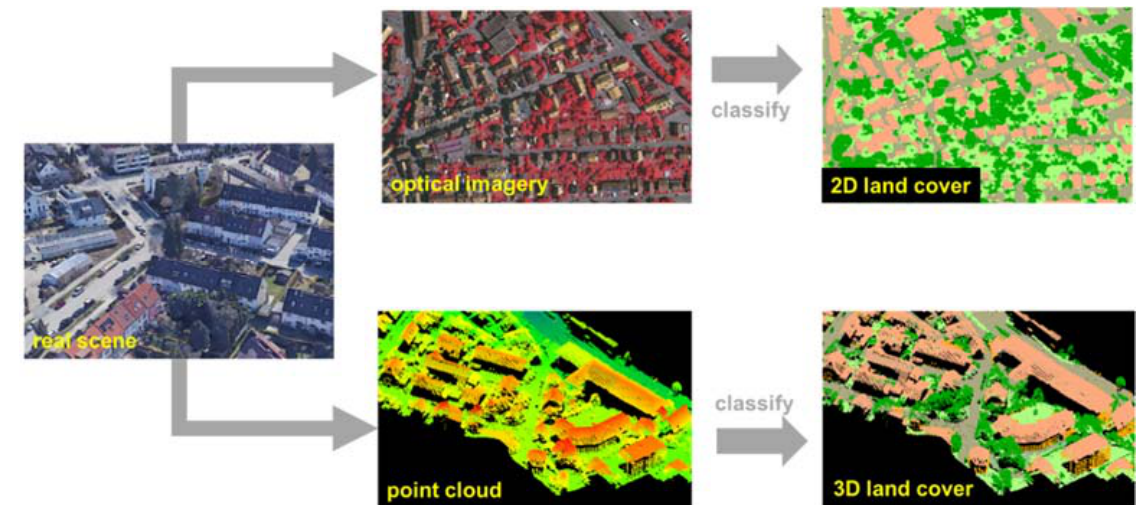
Figure 1. Schematic diagram of two-dimensional (2D) and three-dimensional (3D) land cover.